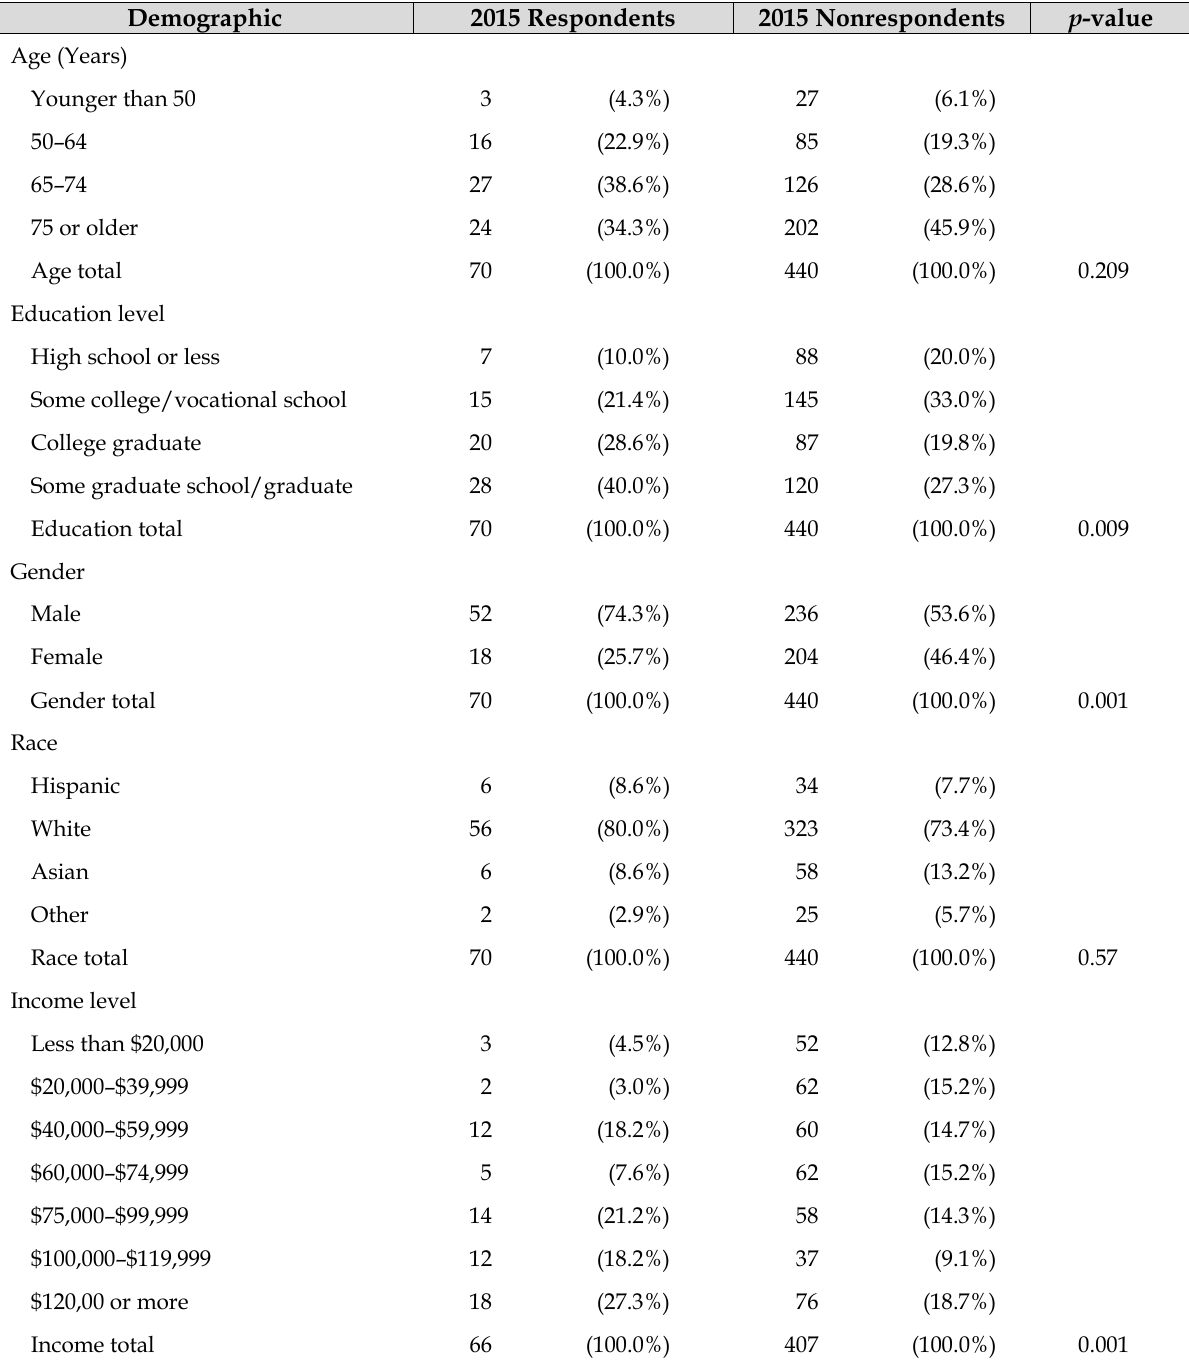
Table 3 2015 Demographics of respondents and